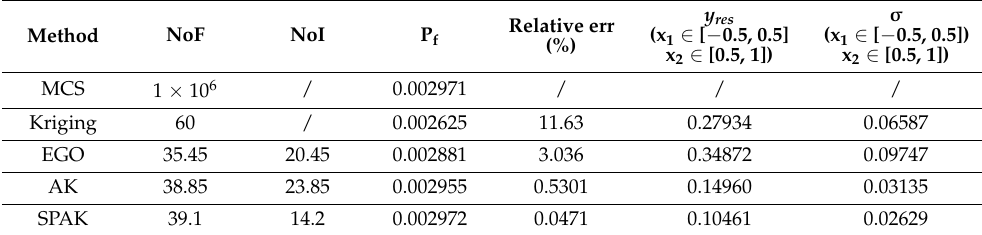
Table 2. Results of different methods for Example